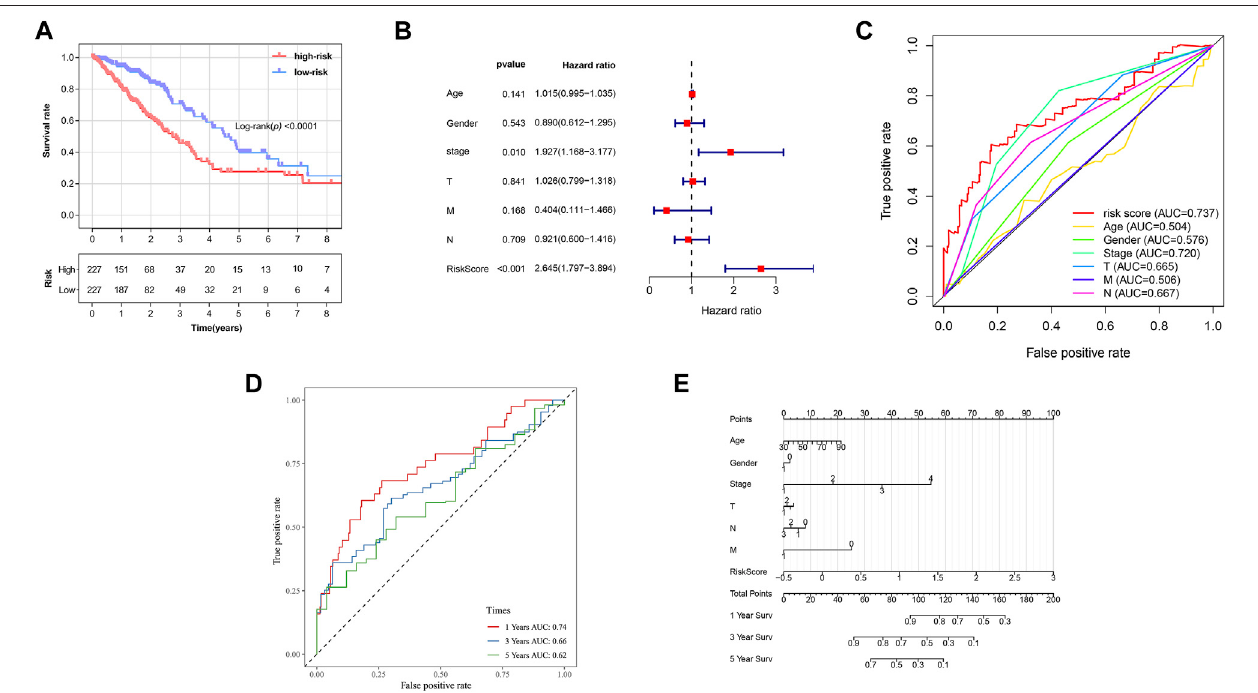
FIGURE 3 | Prognostic analysis of ferroptosis-related gene signature in the TCGA tumor cohort. (A) Kaplan – Meier survival curve of the high- and low-risk groups. (B) Multivariate Cox regression analysis on overall survival. (C) ROC curves for predicting the overall survival of clinical factors and risk score. (D) ROC curves for predicting the 1-, 3-, and 5-year survival of risk score. (E) Nomogram for predicting overall survival. Gender: 1, male; 0, female. Surv: survival. ROC: receiver operating characteristic curve. AUC: area under the